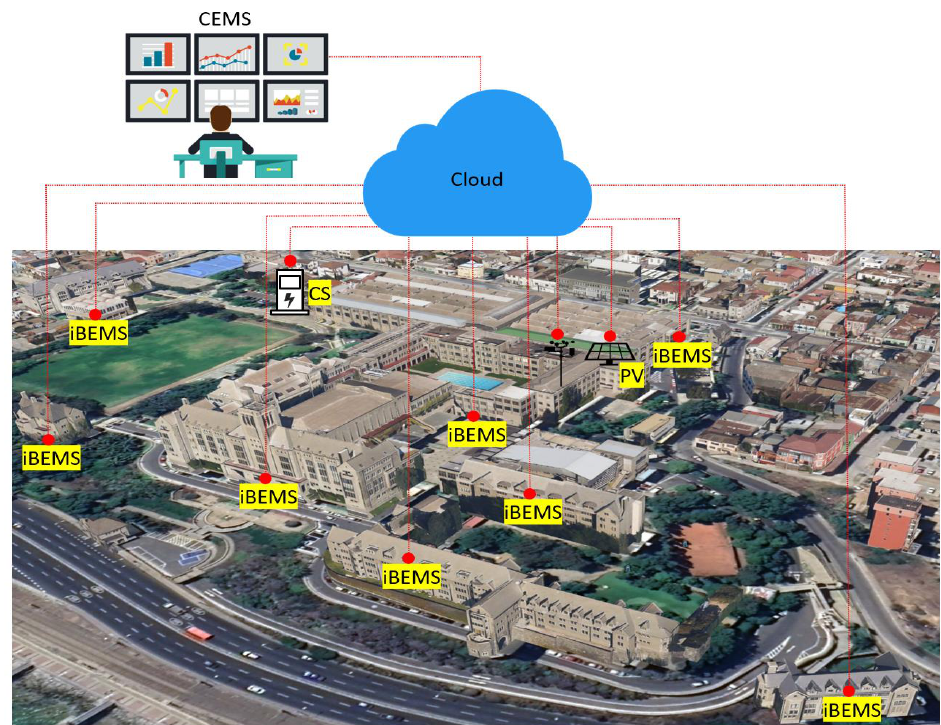
Figure 1. The schematic diagram for the intelligent campus. CEMS: campus energy management system; iBEMS: intelligent building energy management system; CS: charging station; PV: photo- voltaic system.